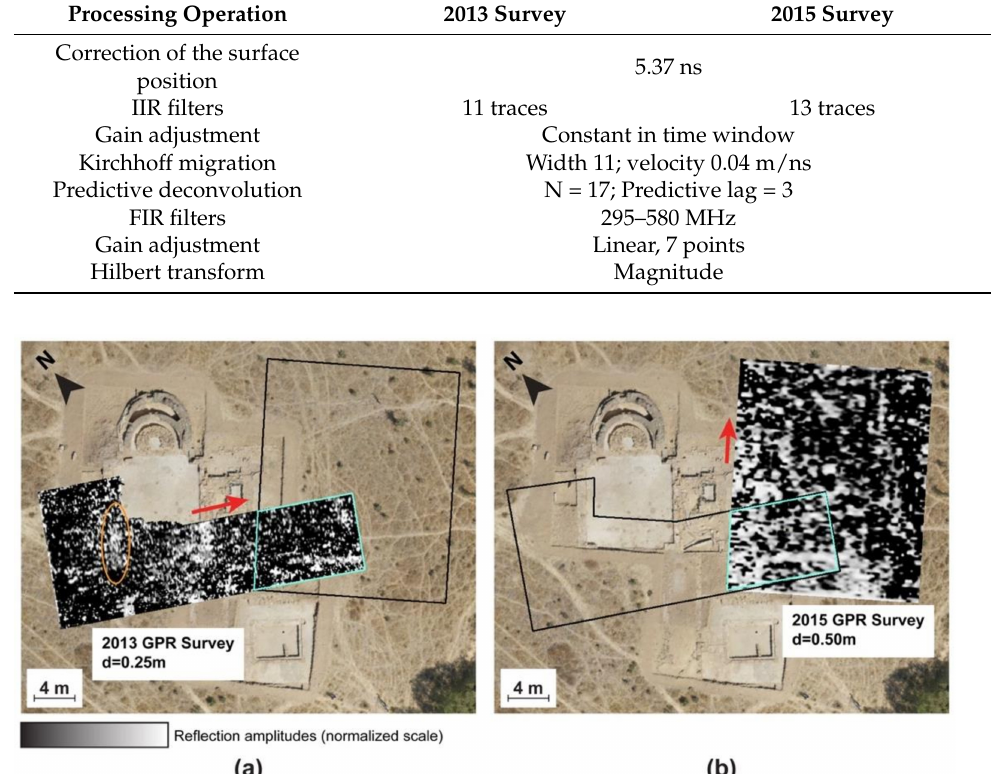
Table 2. Processing parameters of GPR datasets, performed in the GSSI RADAN software.